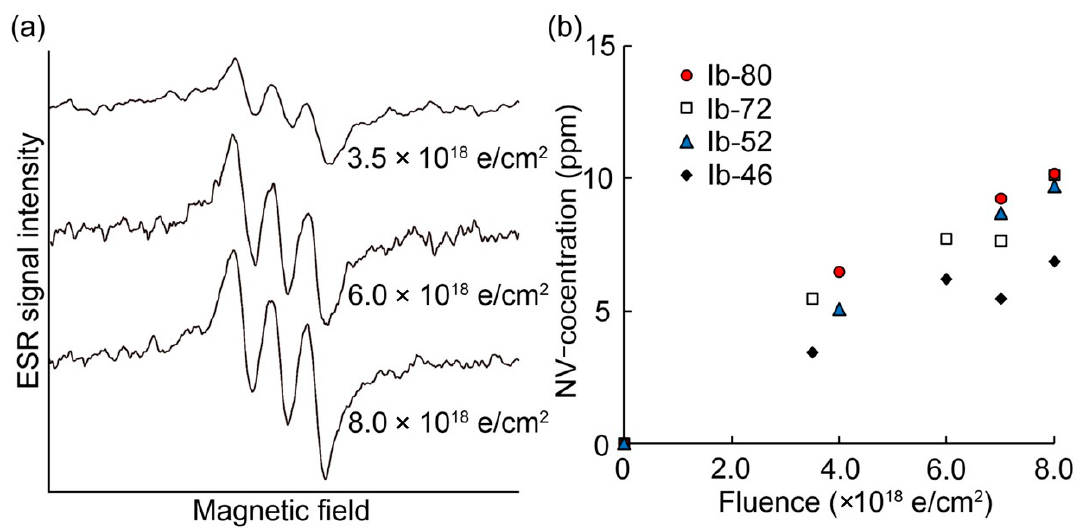
Figure 4. ESR measurement of NV − center in type-Ib diamonds after irradiation and subsequent annealing. ( a ) Typical ESR spectra of a left most peak of NV − center at the different irradiation fluence for Ib-46. ([111]//B 0 ) ( b ) Irradiation fluence dependence of NV − center concentration ([NV − ]) for Ib-80 (closed red circles), Ib-72 (open black circles), Ib-52 (closed blue circles), Ib-46 (closed black circles), respectively.